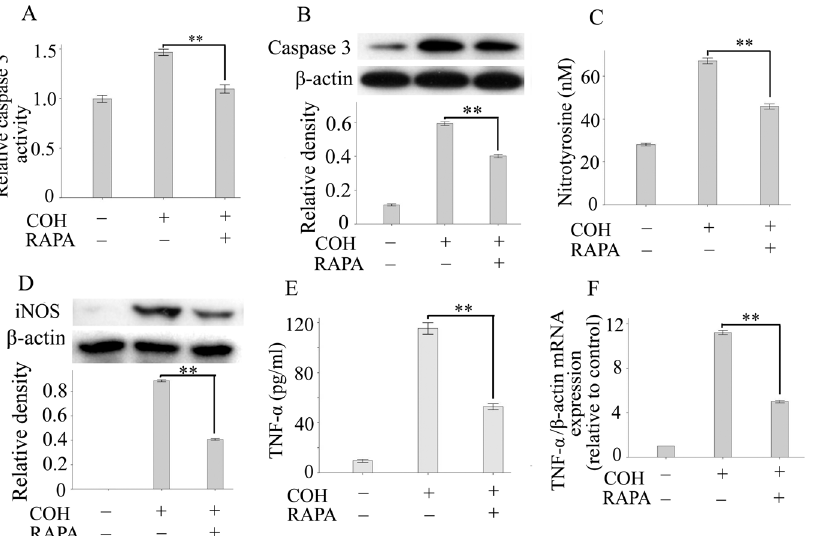
Figure 2. Rapamycin treatment inhibited apoptosis signaling and neurotoxic mediator release in COH retinas. Caspase-3 activity (A) and the expression of active caspase-3 (B) in retinas were detected by ELISA and western blotting, respectively. (C): The nitrotyrosine content in retinas was determined using the OxiSelectTM Nitrotyrosine ELISA Kit. (D): The level of iNOS in retinas was measured by western blotting. TNF- a protein (E) and mRNA expression (F) was determined based on real-time PCR and ELISA. Each group includes 8 rats, and experiments were repeated once. Values are presented as the mean 6 SEM of 3 replicates. ** P , 0.01. Abbreviations: COH, chronic ocular hypertension model; RAPA, rapamycin; iNOS, induced nitric oxide synthase; TNF- a , tumor necrosis